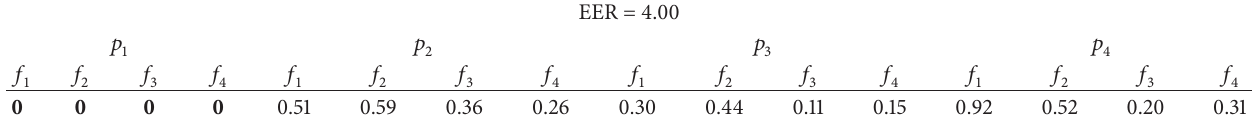
Table 14: Equal error rate with 12 images with optimized weights.